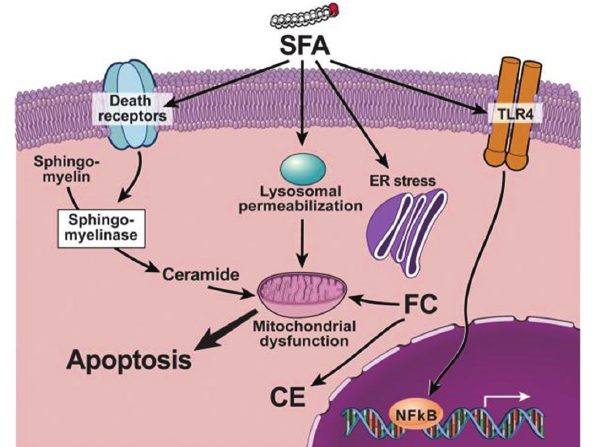
Figure 2: Reference [74]. FFA may activate several signaling path- ways of apoptosis including upregulation and increased number of death receptors such as Fas and TRAIL receptor 5 (DR5), at the level of the plasma membrane, lysosomal permeabilization, and ER stress both coupled to mitochondrial dysfunction resulting in activation of the mitochondrial pathway of apoptosis. These toxic fatty acids may also activate TLR4 signaling resulting in up-regulation of several pro-inflammatory cytokines. Finally, other lipid types such as free cholesterol (FC) and ceramide may induce mitochondrial dysfunction and activate the mitochondrial pathway of